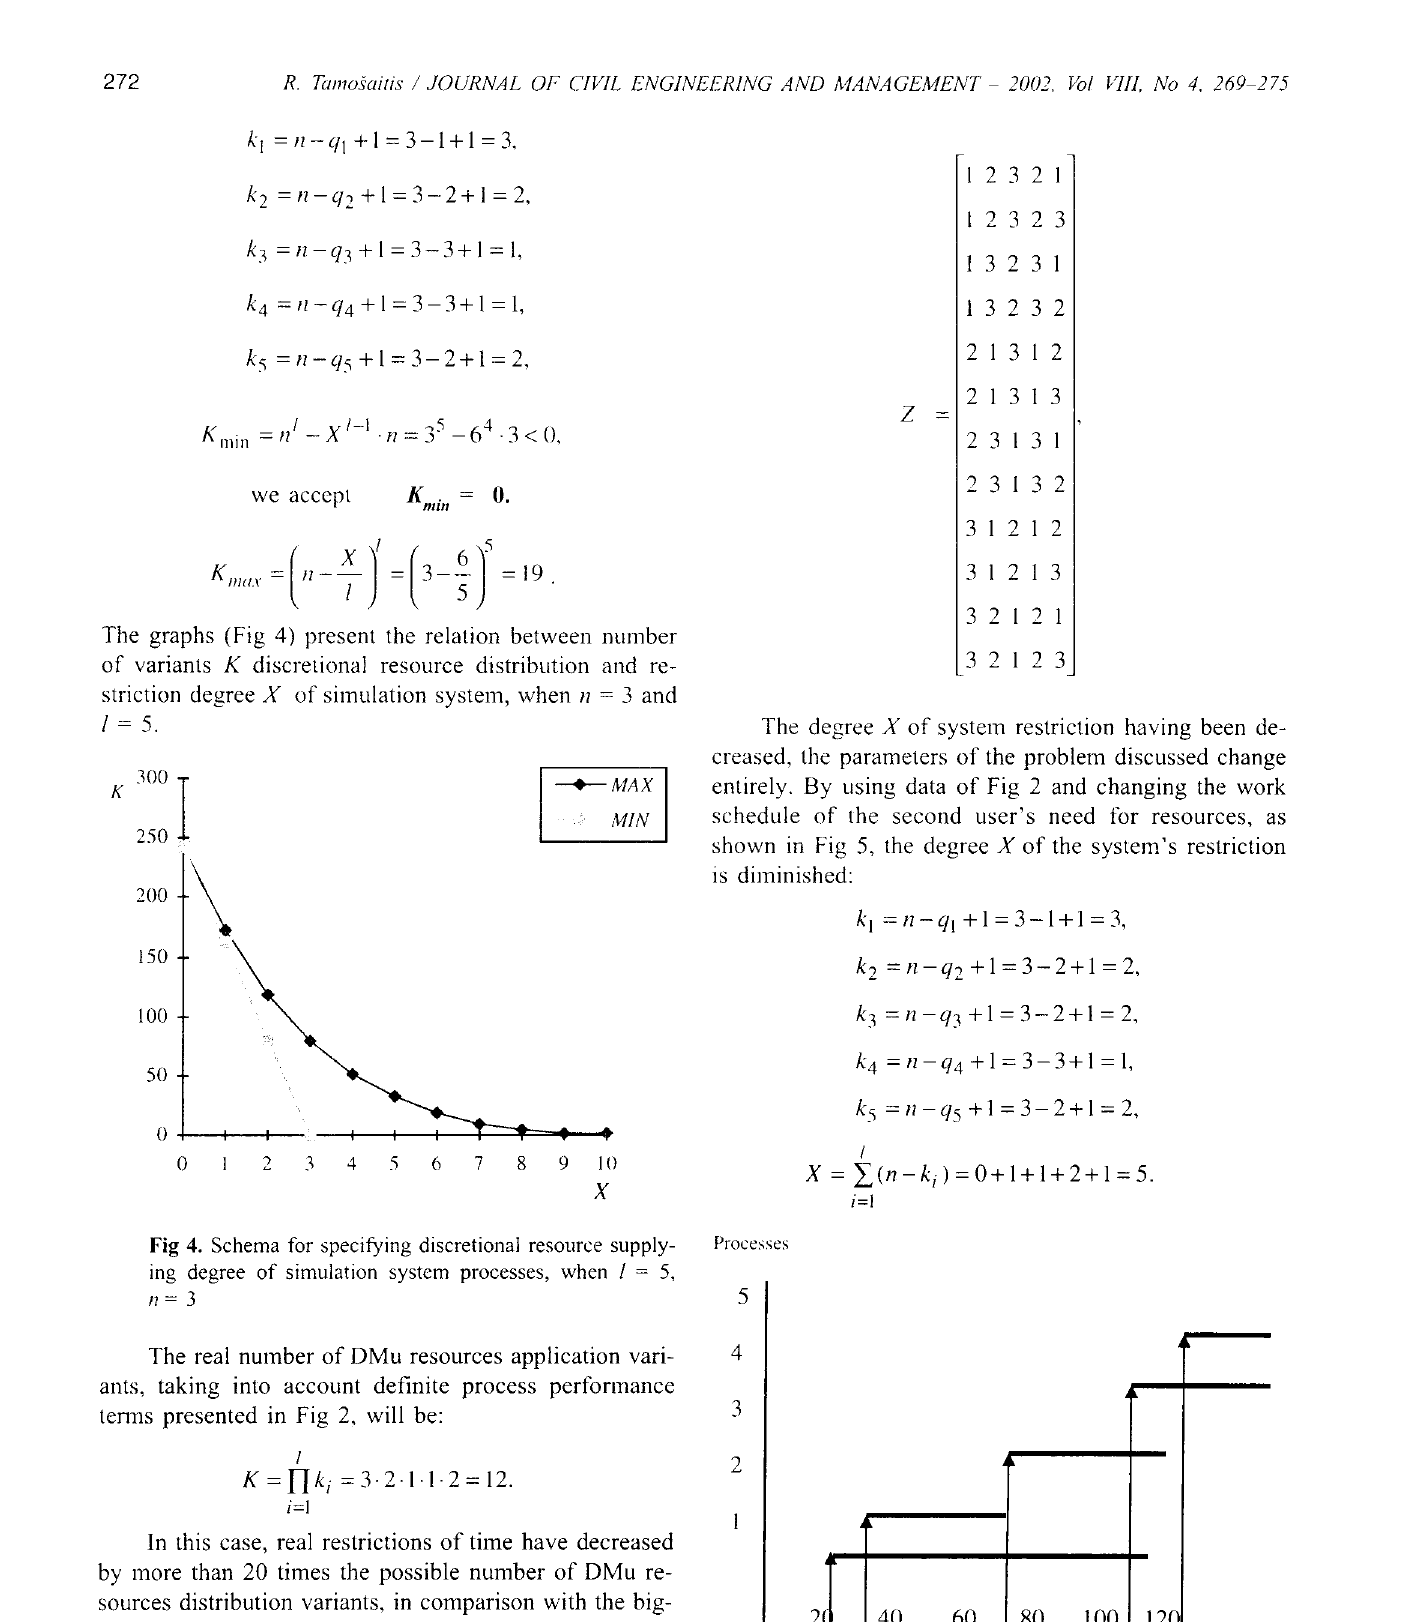
Fig 5. Schema for specifying discretional resource supply ing degree of simulation system processes, when X =